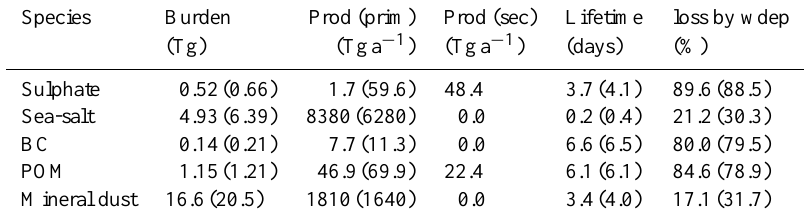
Table 6. Annual mean global mass burden (Tg), production fluxes (Tg/yr) and lifetime (days) for each simulated aerosol component. Also shown in the % removal by wet deposition for each component. In parentheses are shown the median burdens and lifetimes simulated by AEROCOM models as documented in Textor et al. (2006). Note that the figures quoted for sulfate as in Tg of